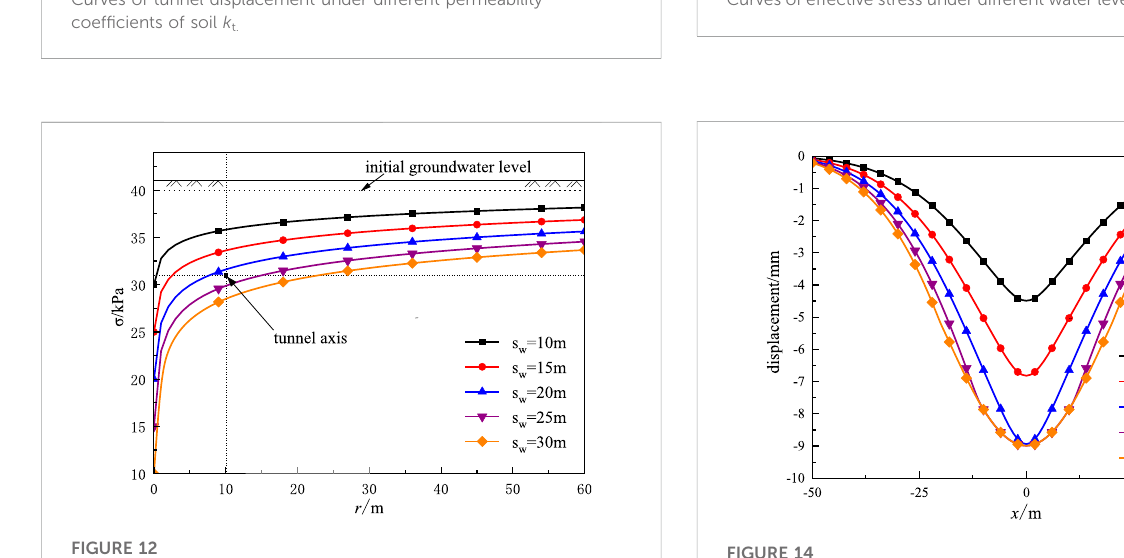
FIGURE 13 Curves of effective stress under different water level drawdown s w.